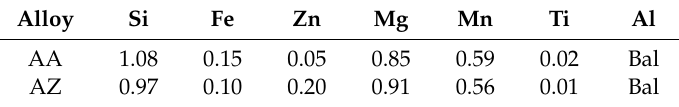
Table 1. Chemical composition of AA and AZ alloys